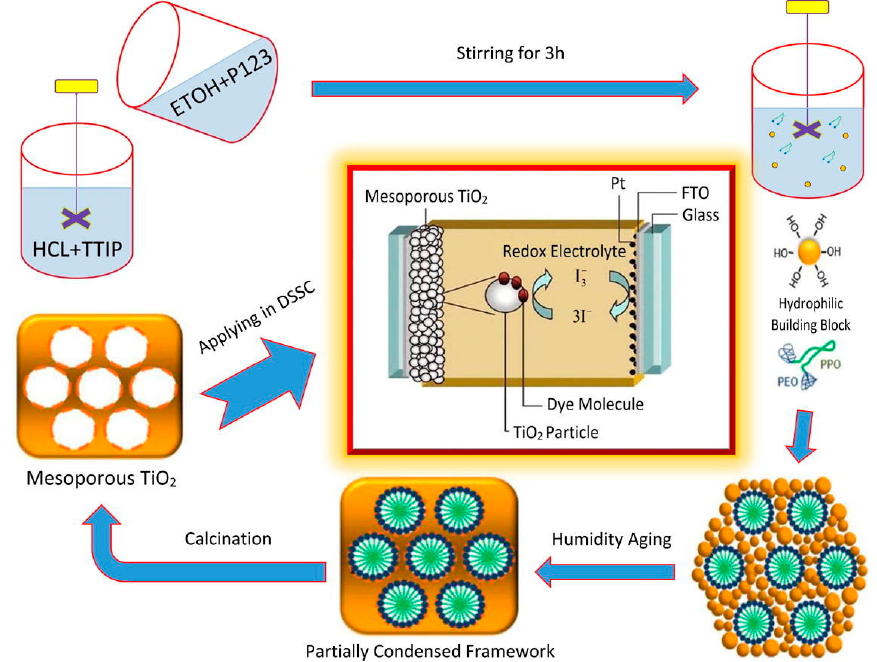
Figure 10. Schematic formation process of the mesoporous TiO 2 via EISA. Reprinted with permission from [38]. Copyright 2018, Elsevier.